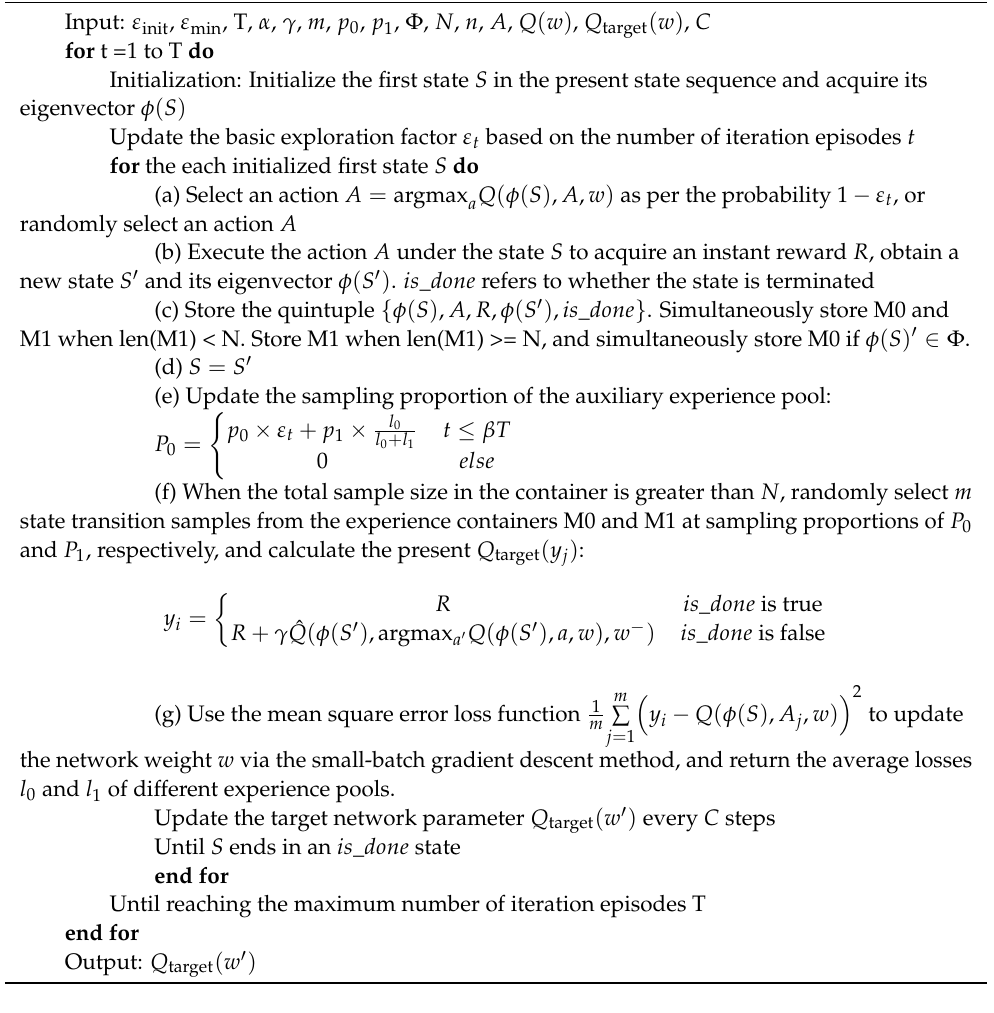
Algorithm 4: Pseudo form of the EC-DDQN